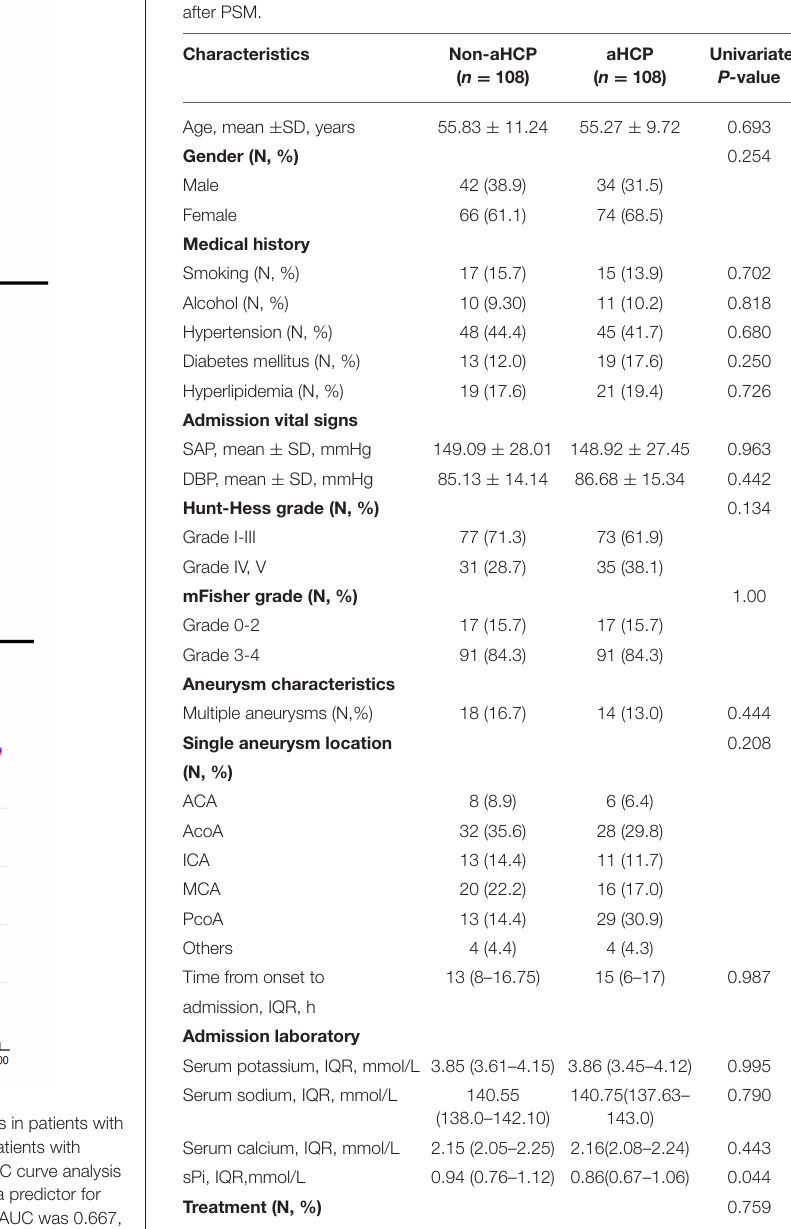
TABLE 2 | Univariate analyses of association with hydrocephalus following aSAH after